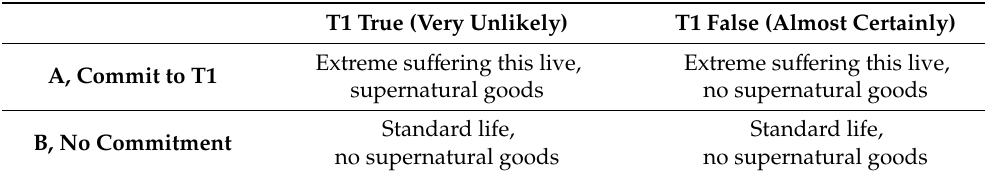
Table 2. Extreme su ff ering and supernatural goods